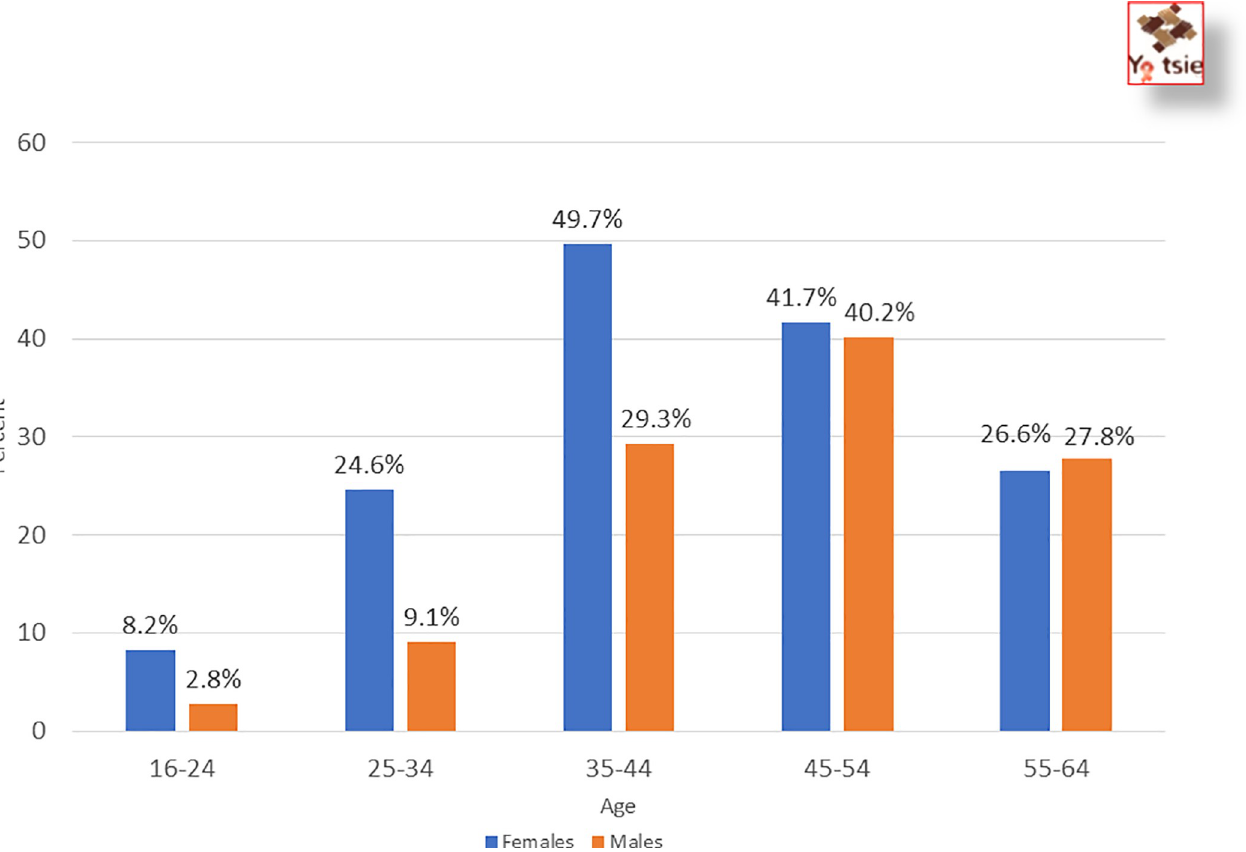
Fig 2. Proportion of HIV-positive persons among persons assessed for HIV by sex & age in 15 intervention communities.